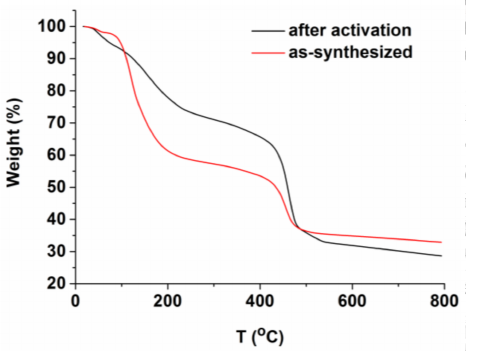
Figure 1. The thermogravimetric analysis (TGA) curves of the as-synthesized and activated samples of metal − organic framework (MOF) 1 showing the continuous weight loss before ca. 500 ◦ C.